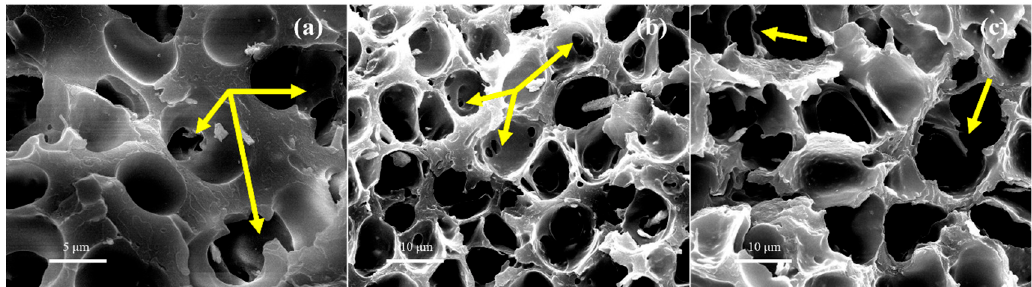
Figure 8. The interconnected pores in SAN/CPE foams. ( a ) 10 wt.% CPE; ( b ) 20 wt.% CPE; ( c ) 30 wt.% CPE; which sample a was foamed at 130 °C and 25 MPa and sample b and c were foamed at 110 °C and 20 MPa.